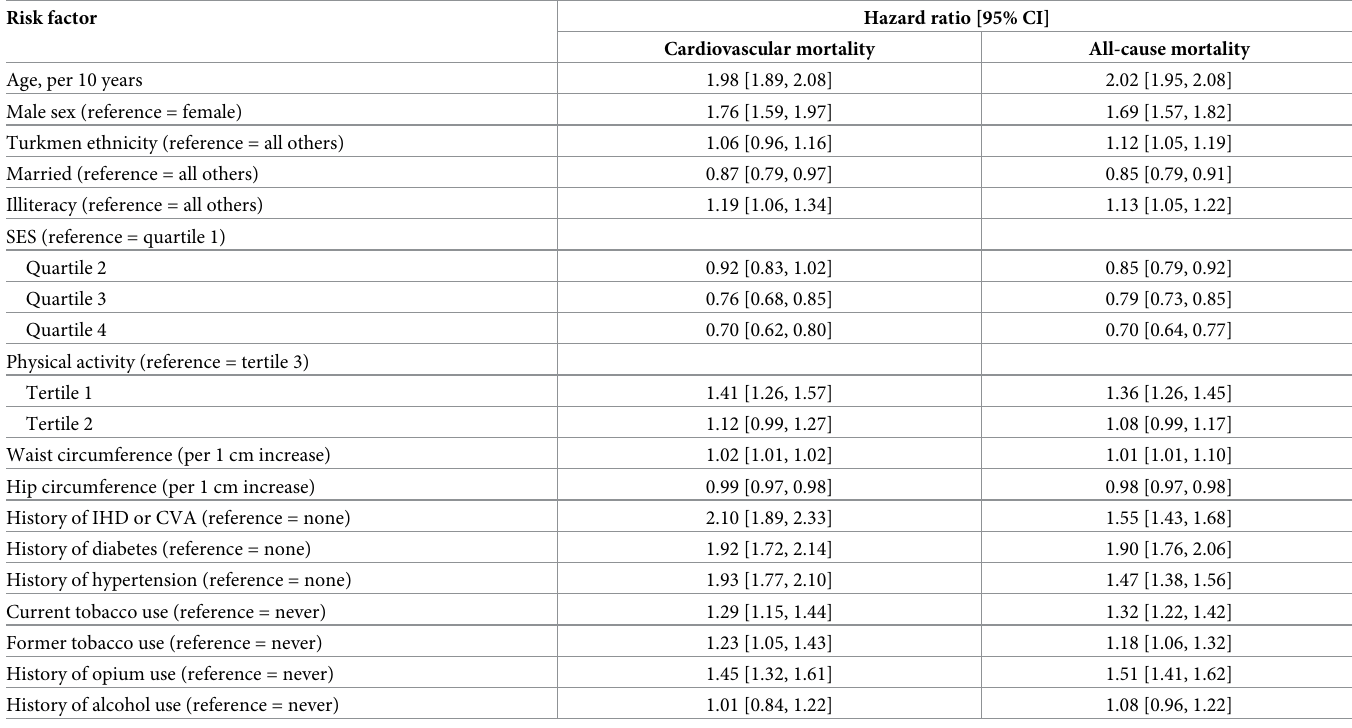
Table 3. Hazard ratios for individual risk